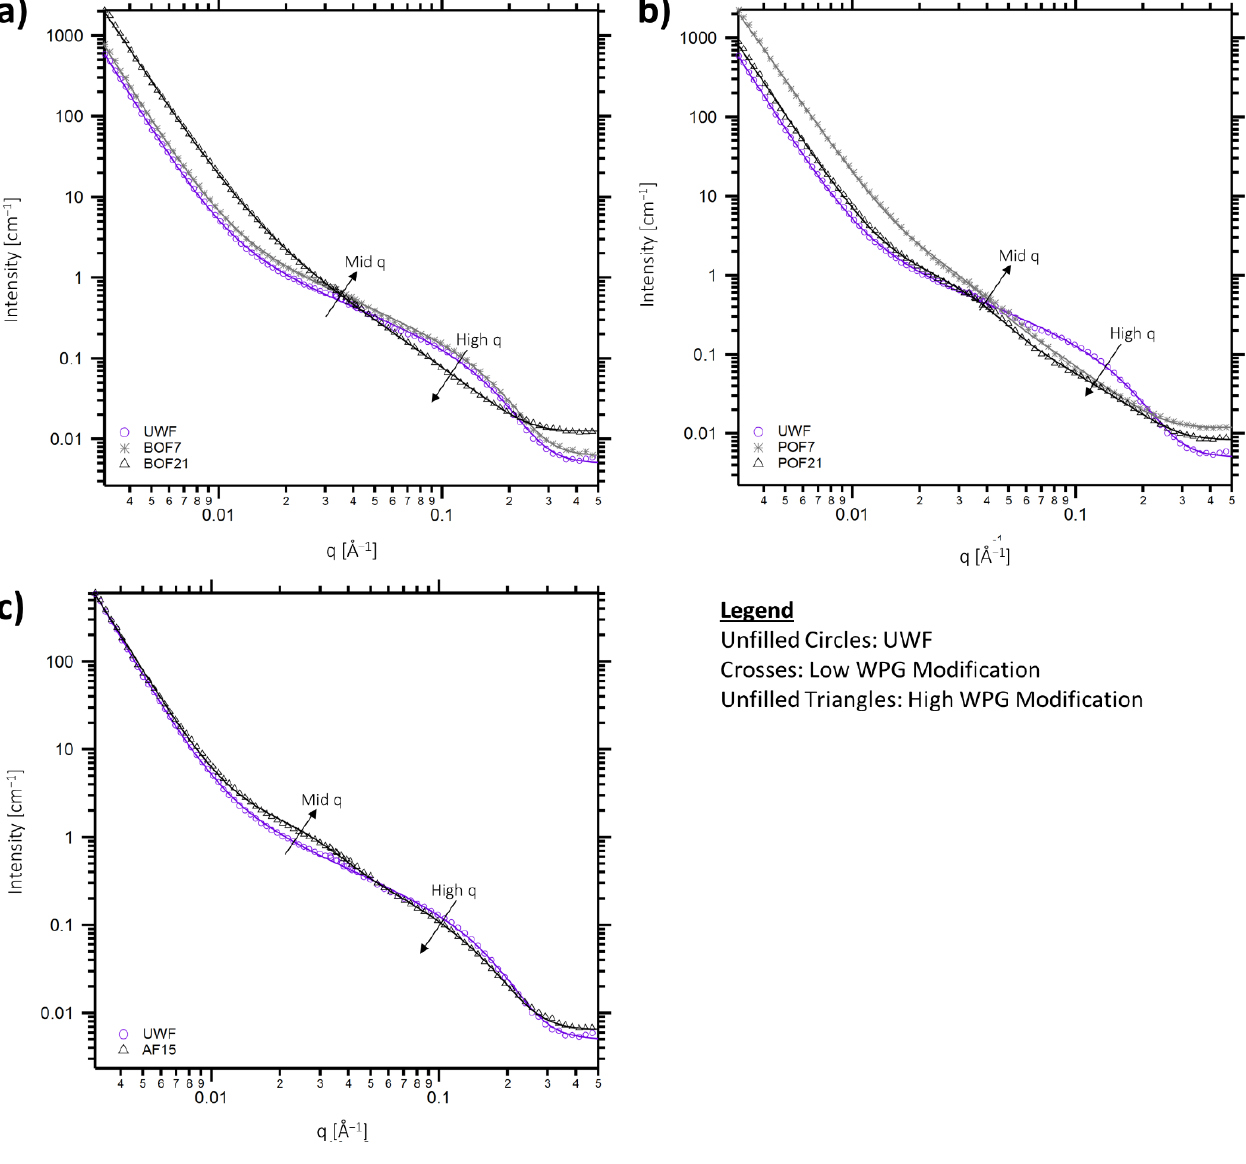
Figure 2. Effects of chemical modification on the SANS profiles obtained from wood fibers modified with ( a ) butylene oxide, ( b ) propylene oxide and ( c ) acetic anhydride. Data is shown as open symbols, and overlaid lines correspond to model fits. The arrows indicate the effects of increasing WPG on the mid-q and high-q scattering regions.